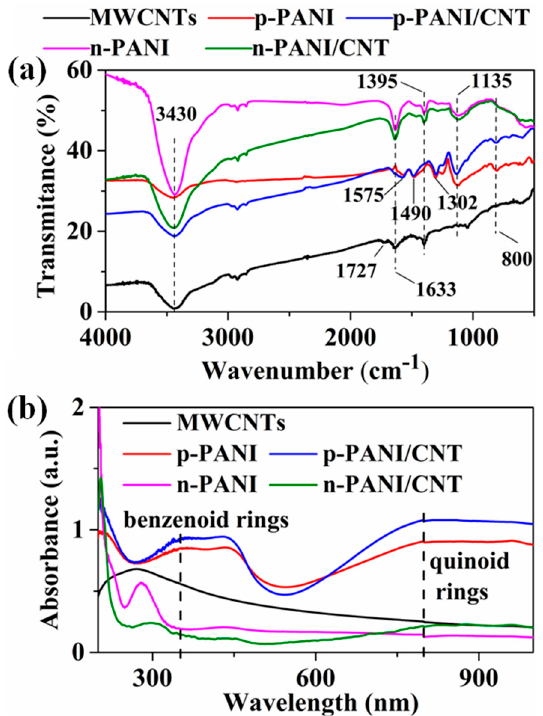
Figure 3. ( a ) FTIR spectra, ( b ) UV-vis spectra of MWCNTs, p-PANI, p-PANI/CNT, n-PANI and n-PANI/CNT fibers.